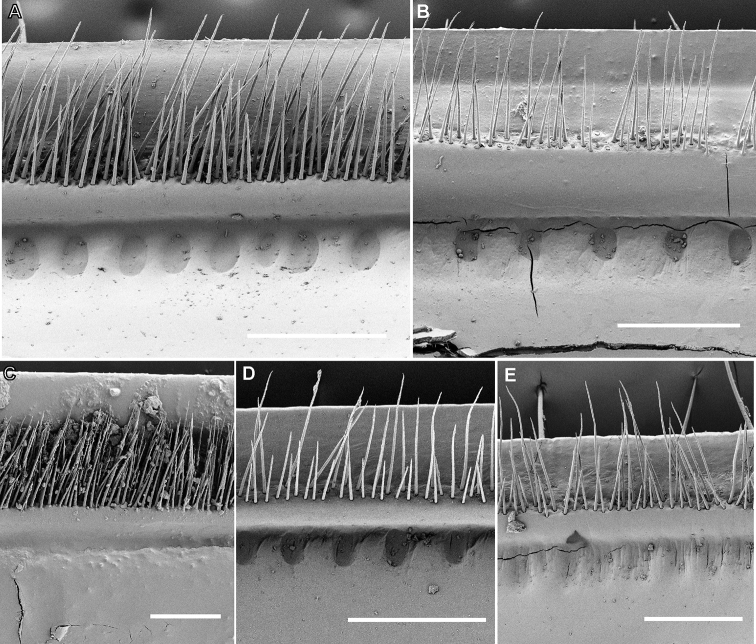
Endoterga of midbody segments, SEM micrographs. ASphaerobelum
bicorne Attems, 1938, ♂ (ZFMK) BSphaerobelum
pumatense sp. nov., ♂ holotype CSphaeropoeus
maculatus (Verhoeff, 1924), ♂ lectotype DSphaeropoeus
bidoupensis sp. nov., ♂ holotype ESphaeropoeus
honbaensis sp. nov., ♂ holotype. Scale bars: 0.2 mm.